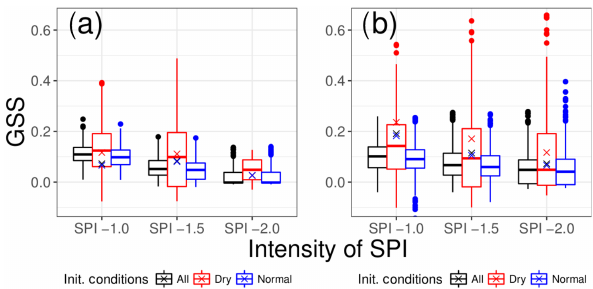
Figure 5. Box plot of the GSS scores in winter using the refer- ence forecast (a) and the operational forecast (b) . The scores are calculated over the entire domain and the boxes display the spatial variability. The scores depend on the SPI intensities ( − 1, − 1 . 5 and − 2, x axis) and the initial conditions defined by the previous ob- served SPI-2 conditions (see text for more details). Crosses indicate the scores but are calculated by merging all the grid